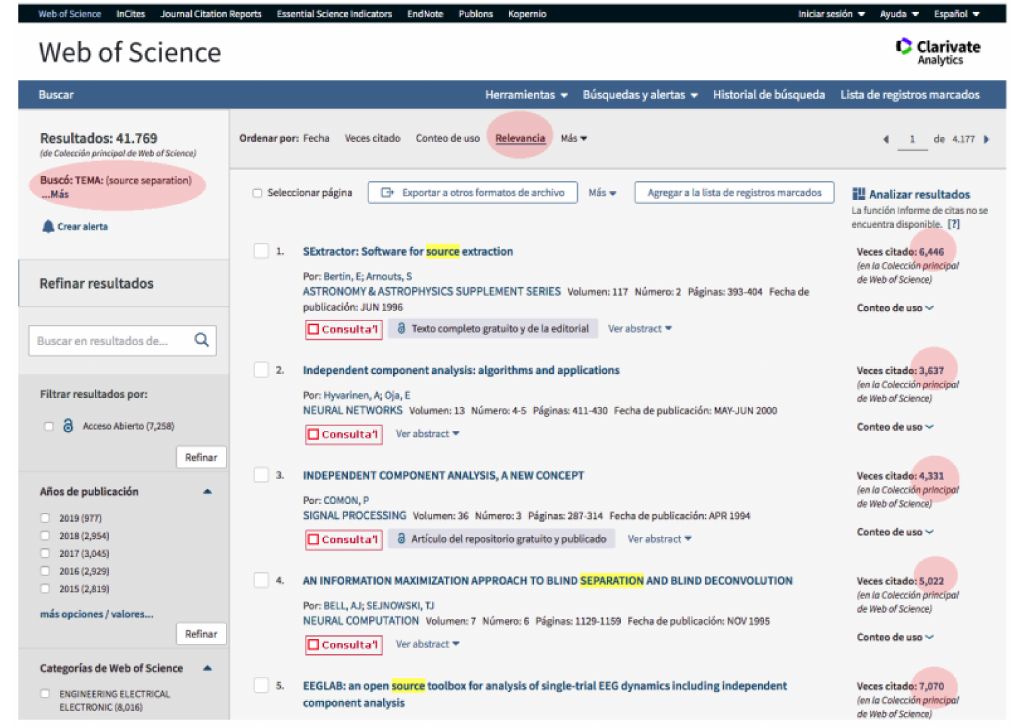
Figure 10. Search conducted on WoS with relevance ranking using the number of citations.